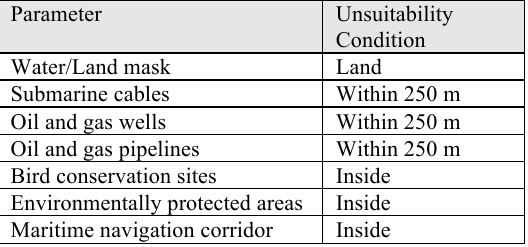
Table 1: Criteria used to exclude areas from the selection process